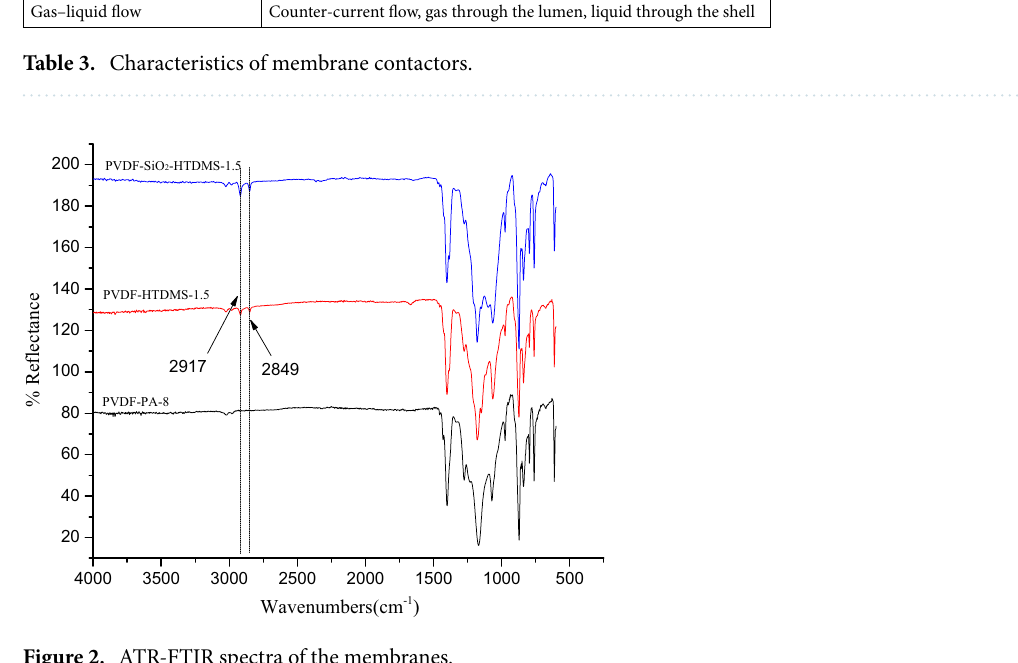
Figure 2. ATR-FTIR spectra of the